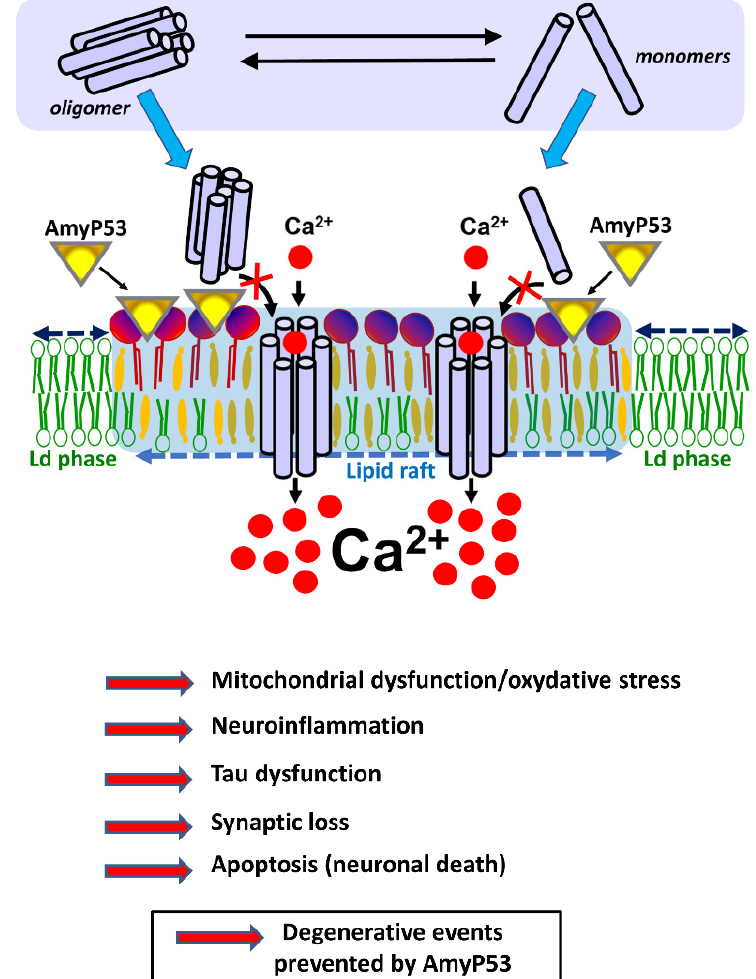
Figure 1. AmyP53 blocks a mechanism of neurotoxicity shared by both Alzheimer’s and Parkinson’s diseases. AmyP53 blocks the neurotoxic cascade triggered by oligomers in the membrane of brain cells. Amyloid pores may be either preassembled in the extracellular space (soluble oligomers, in equilibrium with monomers and intermediate assemblies) or within the plasma membrane of brain cells (from monomers that bind to the membrane). Yet in both cases the formation of these amyloid pores requires gangliosides that act as specific membrane receptors. Ca 2+ ions rush into these pores, triggering a cascade of neurotoxic events that disrupt brain activity and precipitate the disease in patients. By preventing any amyloid protein from binding to gangliosides, AmyP53 blocks the overall neurotoxicity cascade at this earliest membrane step that is common to both Alzheimer’s and Parkinson’s